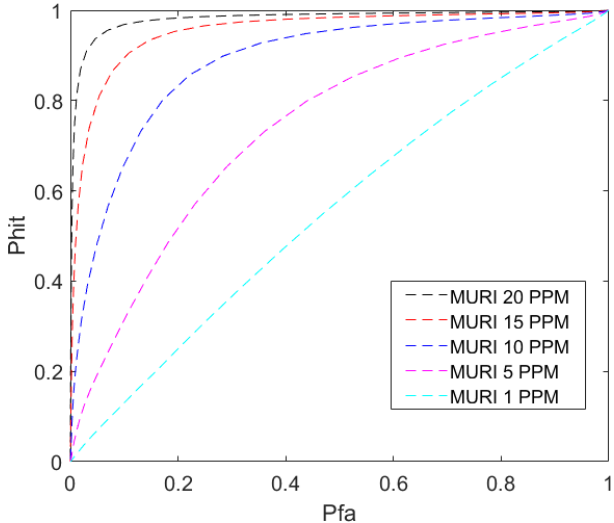
Figure 8. ROC curve describing the performance of applying the NDMI to the simulated data set using the methane feature band, band 1, and the MURI band with the least powerful methane signa- ture, band 6 (see Table S3 for the area under each